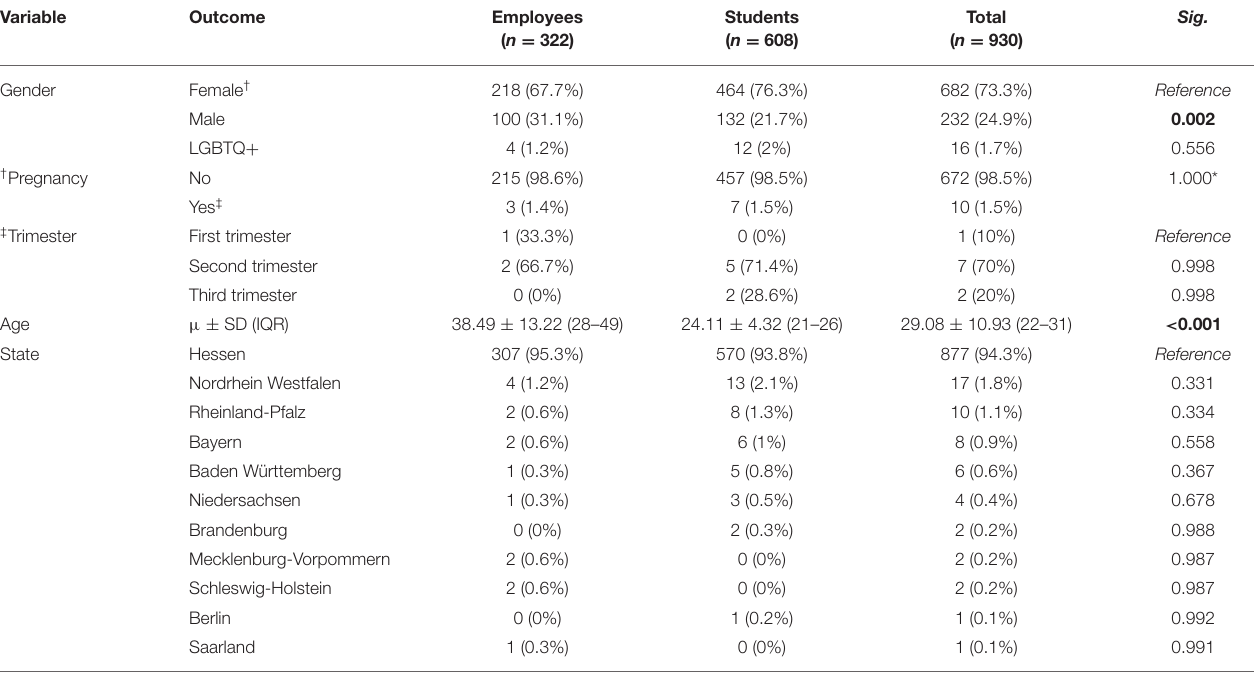
TABLE 1 | Demographic characteristics of German university students and employees participating in the COVID-19 Vaccine Booster Hesitancy (VBH) Survey, december 2021 ( n = 930).